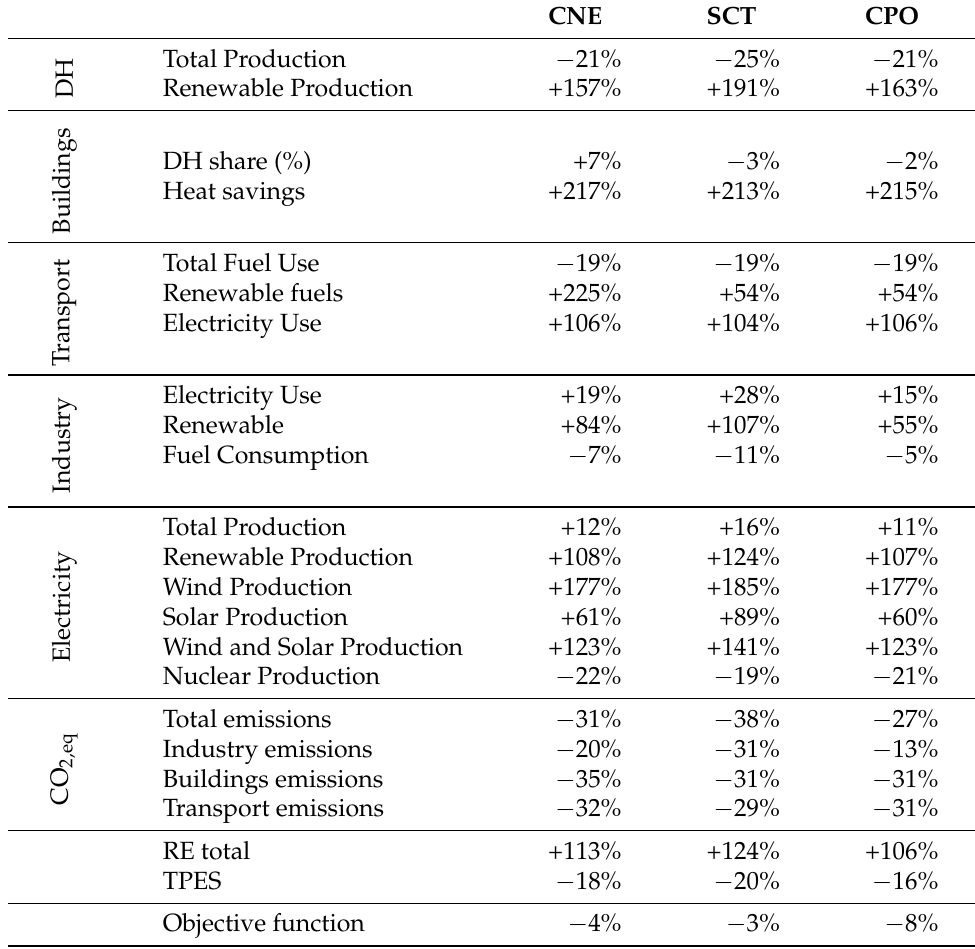
Table 1. Summary of results for the alternative scenarios for the period